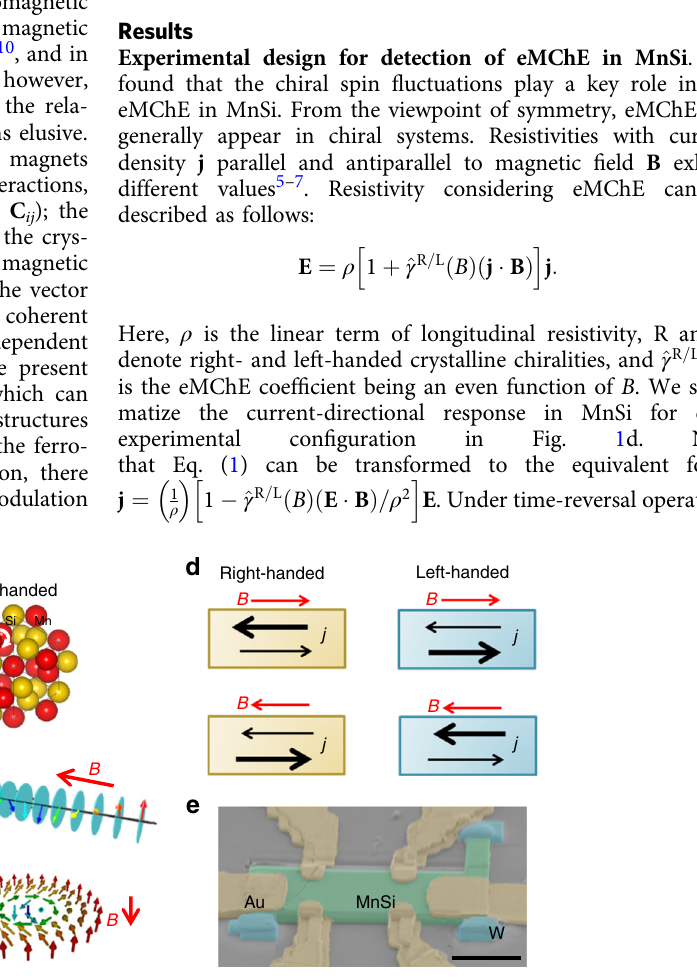
Fig. 1 Crystal and spin structures of MnSi, and experimental con fi gurations. a – c Crystal structures of right- and left-handed MnSi viewed from the [111] direction a and the corresponding spin structures of helical orders b and skyrmions c . We de fi ne the right- and left-handed MnSi as the atomic coordinates ( u , u , u ), (1/2 + u , 1/2 − u , 1/2 − u ), (1/2 − u , − u , 1/2 + u ), ( − u , 1/2 + u , 1/2 − u ) with u Mn = 0.863, u Si = 0.155 and with u Mn = 0.137, u Si = 0.845, respectively. d Experimental con fi gurations for measurements of electrical magnetochiral effect and expected dichroic properties of current density. The bold arrows schematically represent paths with the larger current density at a constant electric fi eld along the arrow direction. e A scanning electron microscope image of a MnSi thin plate sample: MnSi crystal (green), gold electrodes (yellow), tungsten for fi xing the sample (light blue), and silicon stage (grey). Scale bar , 5 μ